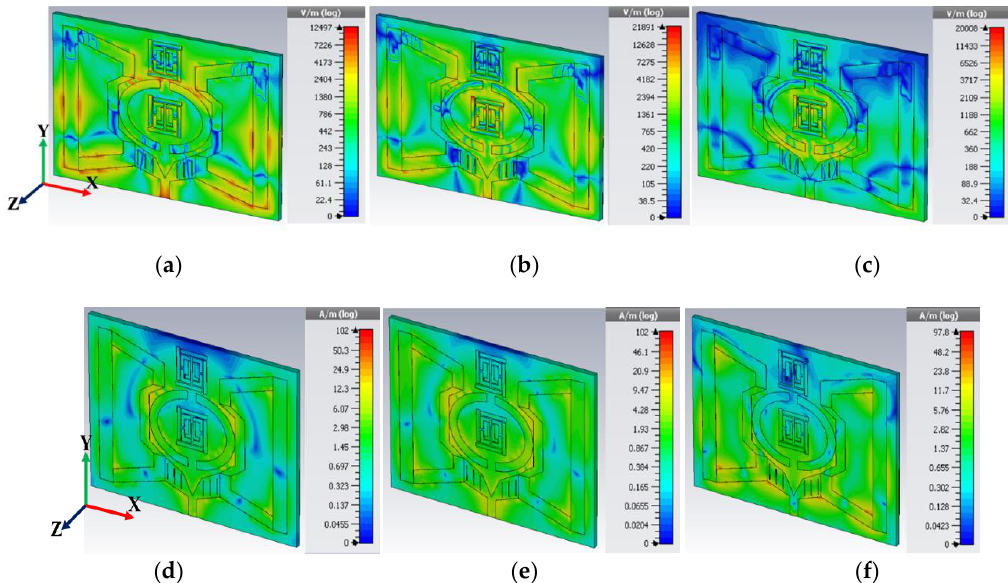
Figure 6. E-field ( a – c ) and H-field ( d – f ) performance of the proposed antenna at 4, 4.27, and 4.4 GHz (left to right, respectively).